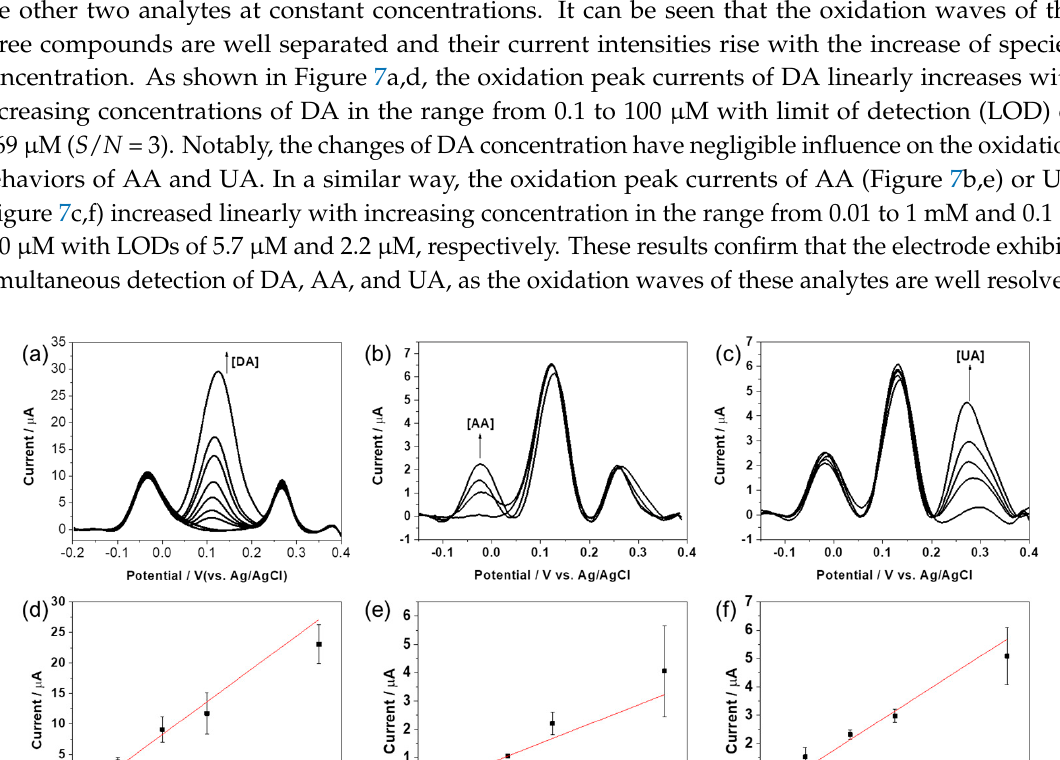
Figure 6. Effect of pH on the peak current and oxidation potential of DA at RGO/AuNPs-GCE.